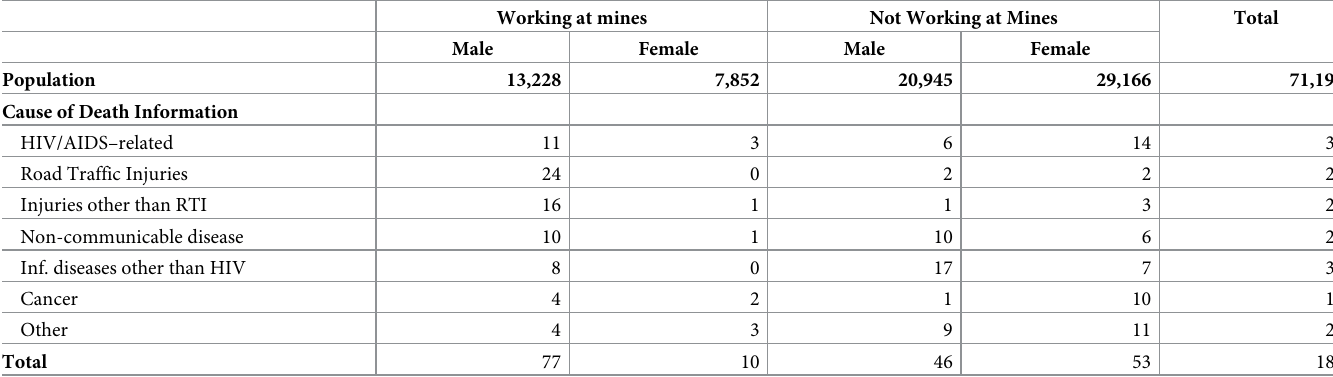
Table 3. Mortality by mining